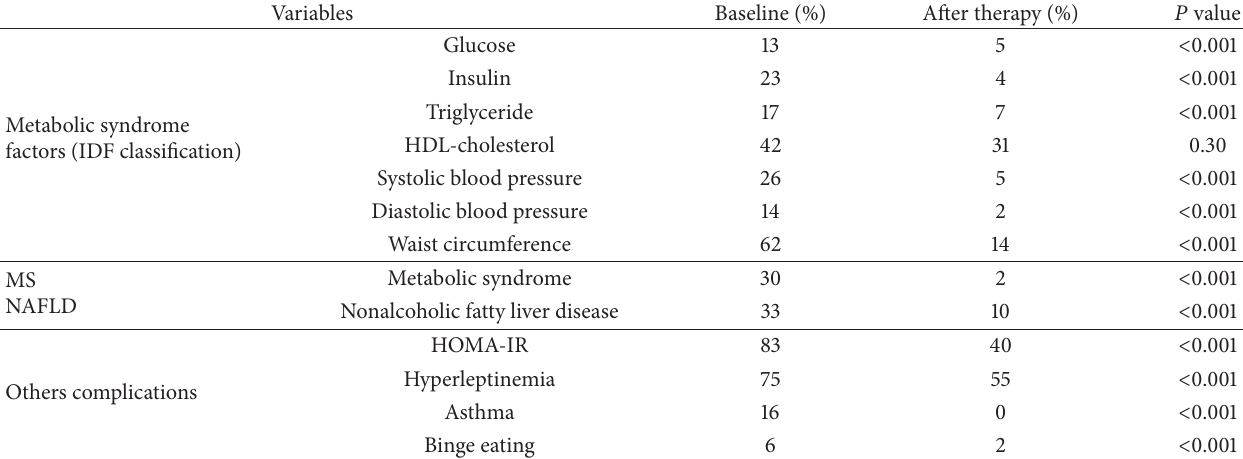
Table 1: Prevalence of metabolic disorders associated with obesity.